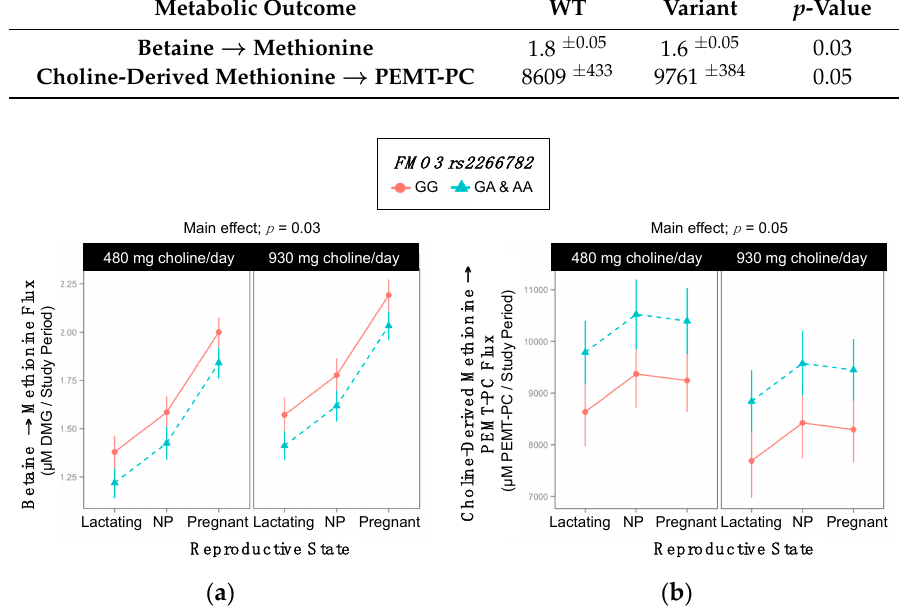
Table 13. FMO3 rs2266782 genotype alters the metabolic flux of plasma choline metabolites. Values are least-squared means ± standard errors for each group. Betaine → methionine values are in µ M methionine/study period, choline → betaine values are in µ M betaine/study period and choline-derived methionine → PEMT-PC values are in µ M PC/study period. Metabolic Outcome WT Betaine → Methionine Choline-Derived Methionine → PEMT-PC